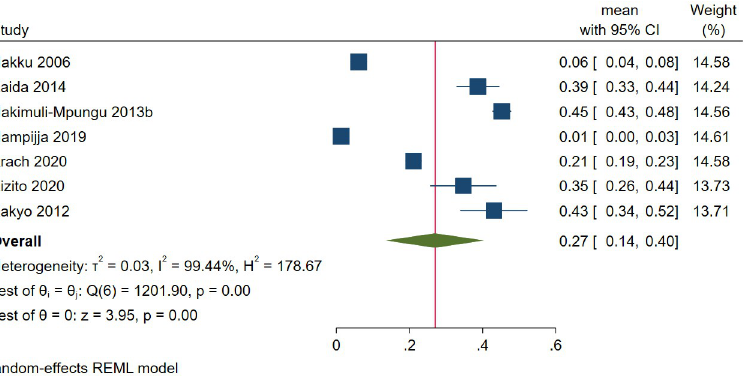
Fig 7. Forest plot on the prevalence of depression among postpartum or pregnant females in Uganda.